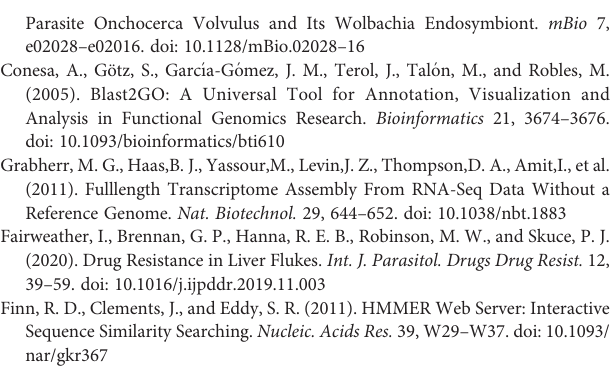
Supplementary Figure 1 | Validation of RNA-seq pro fi les by quantitative real- time